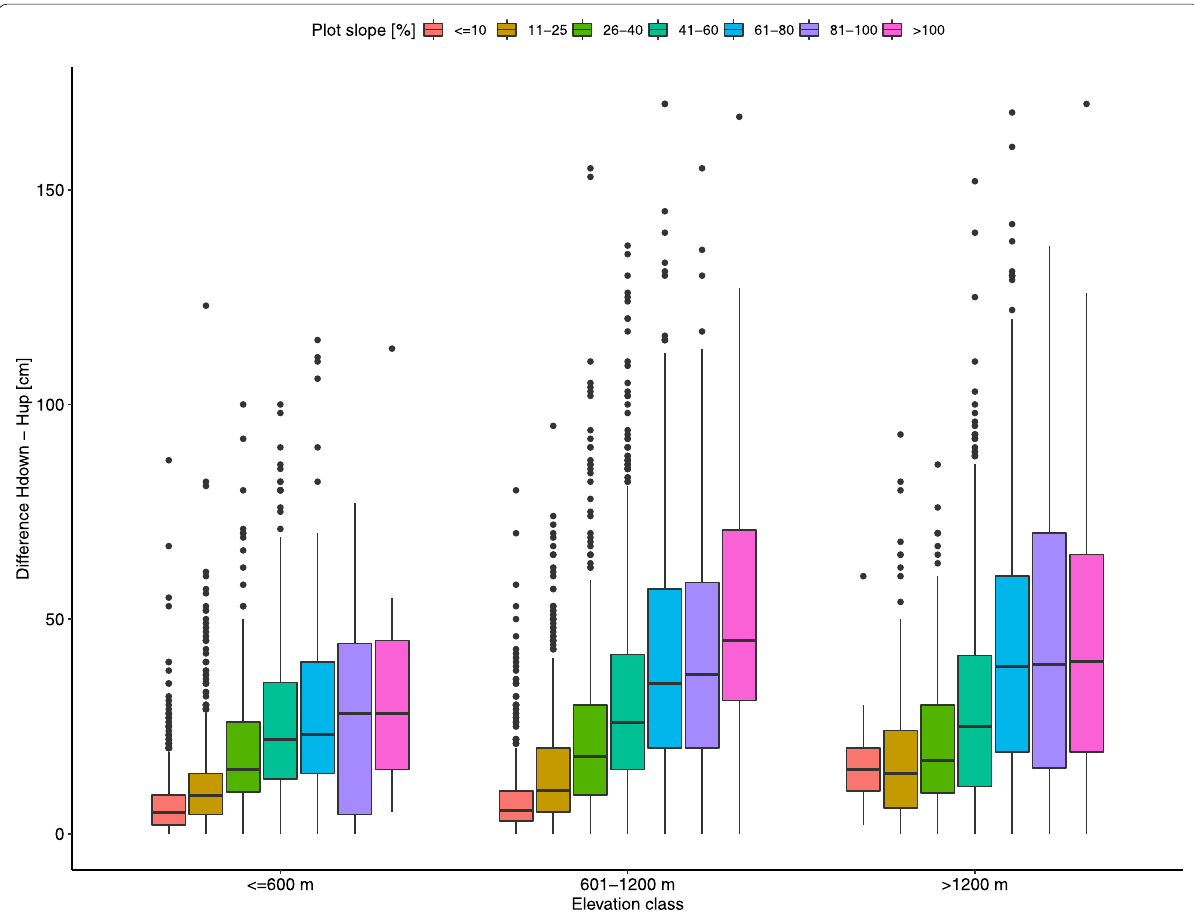
Fig. 7 Data from the NFI5 stump inventory for 6961 inventoried stumps on the difference between the heights measured on the downslope and the upslope facing sides stratified by elevation class and percent